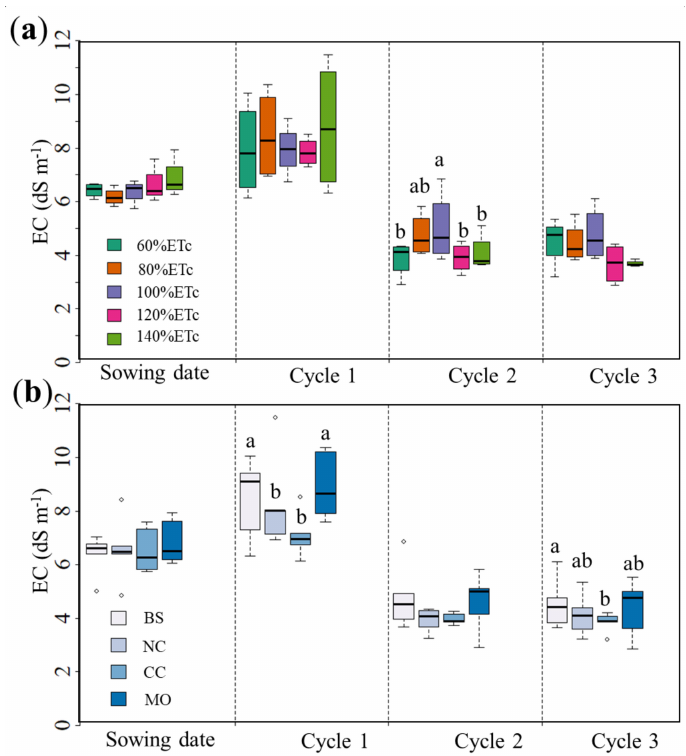
Figure 7. Box plot for soil electrical conductivity (EC) as a function of irrigation depths with wastewater ( a ) and soil use conditions ( b ). The means were compared using Tukey’s test ( p < 0.05) and are indicated by lowercase